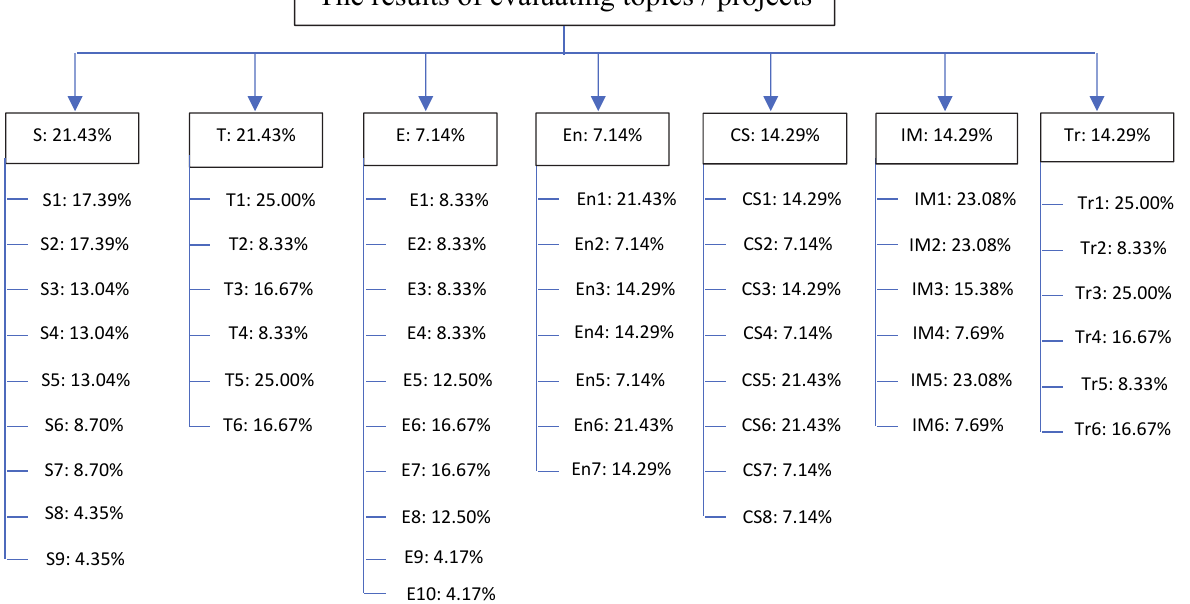
Fig. 6. Weight of each criterion for evaluating socio-economic efficiency of medical sciences topics /projects